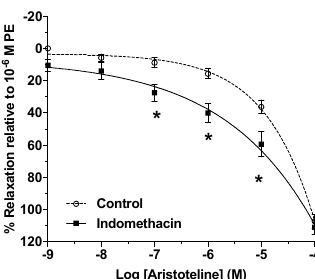
Figure 10. Evaluation of the ARI vasodilatation mechanism associated with endothelial prostanoids. Data shows the effect of ARI after the addition of indomethacin (10 μ M) as a non-selective cyclooxygenase inhibitor. PE (1 μ M) was used to induce the contractile responses. The determination of IC 50 were performed using nonlinear regression and a repeated-measures two-way ANOVA to compare curves; n = 6. Statistically significant difference * p < 0.05 vs. Control.